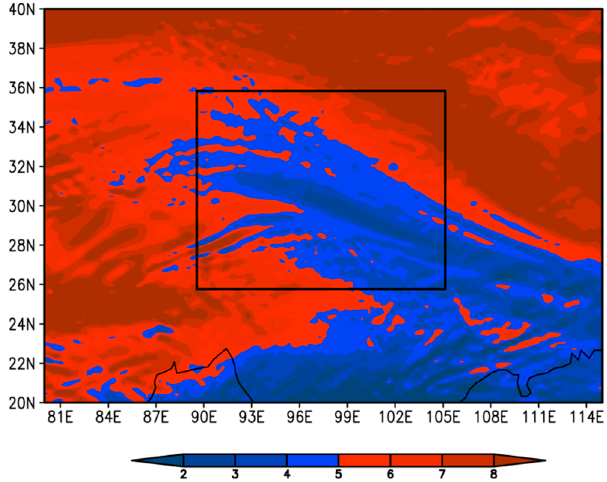
Figure 4. Mean PV (shaded; unit: PVU) of WRF outputs between the 100 hPa and 200 hPa isobaric surfaces at 0600 UTC 15 March 2006. The initial positions of the released particles are located in the black frame.